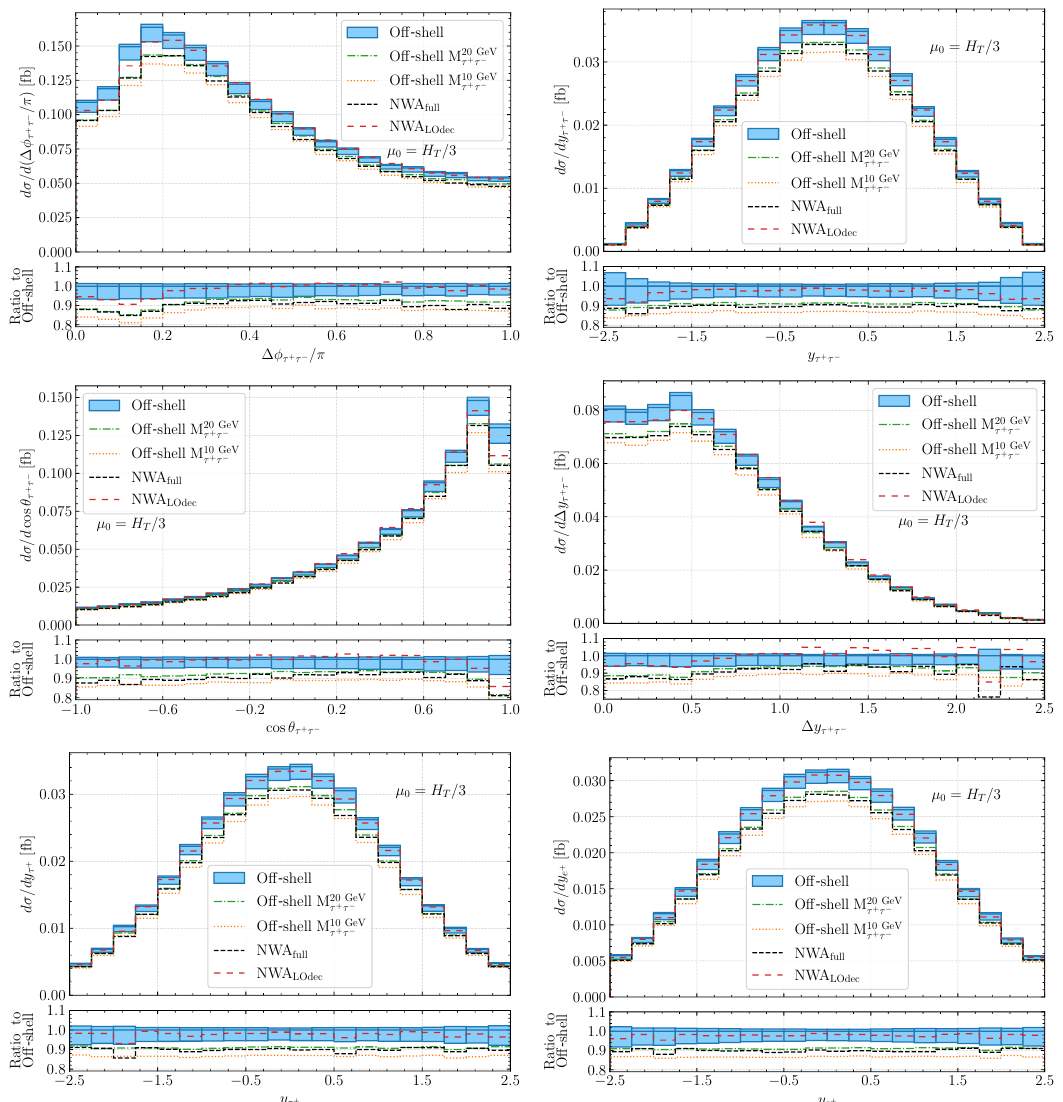
Figure 12 . Differential cross-section distributions for pp → e + ν e µ − ¯ ν µ b ¯ b τ + τ − + X at the LHC with √ s = 13 TeV as a function of ∆ φ shows the NLO QCD prediction for the full off-shell case as well as for NWA full and NWA LOdec . Also given is the full off-shell result with the additional | M we provide theoretical uncertainties as obtained from the scale dependence for the full off-shell case. The lower panel displays the ratios to the full off-shell result. The scale choice is µ R = µ F = µ 0 = H T / 3 . The cross sections are evaluated with the NNPDF3.1 PDF